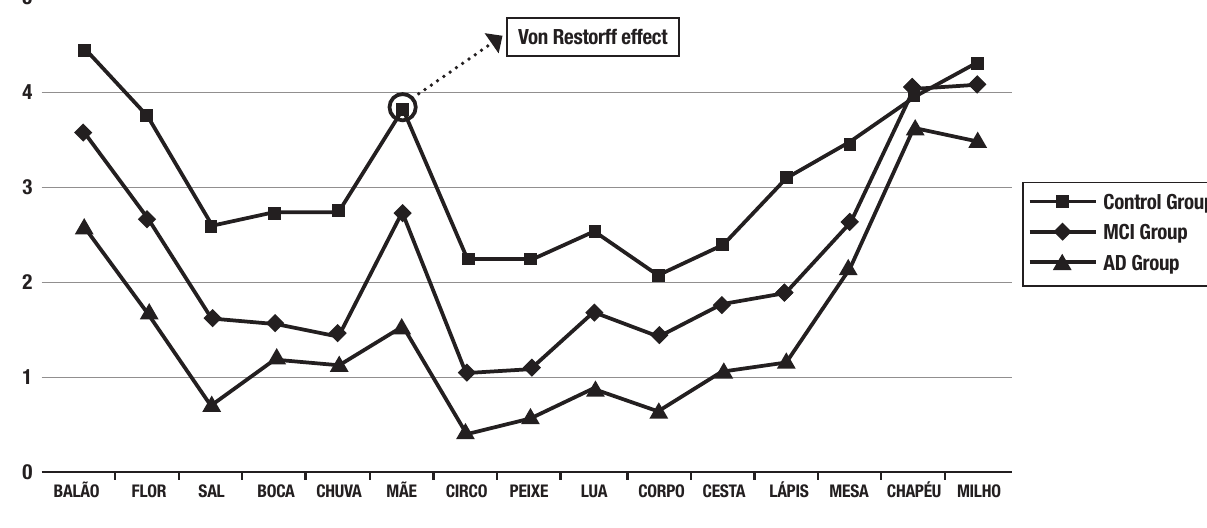
Figure 2. Serial position curve for all three groups. Original words (in Portuguese) from the RAVLT are